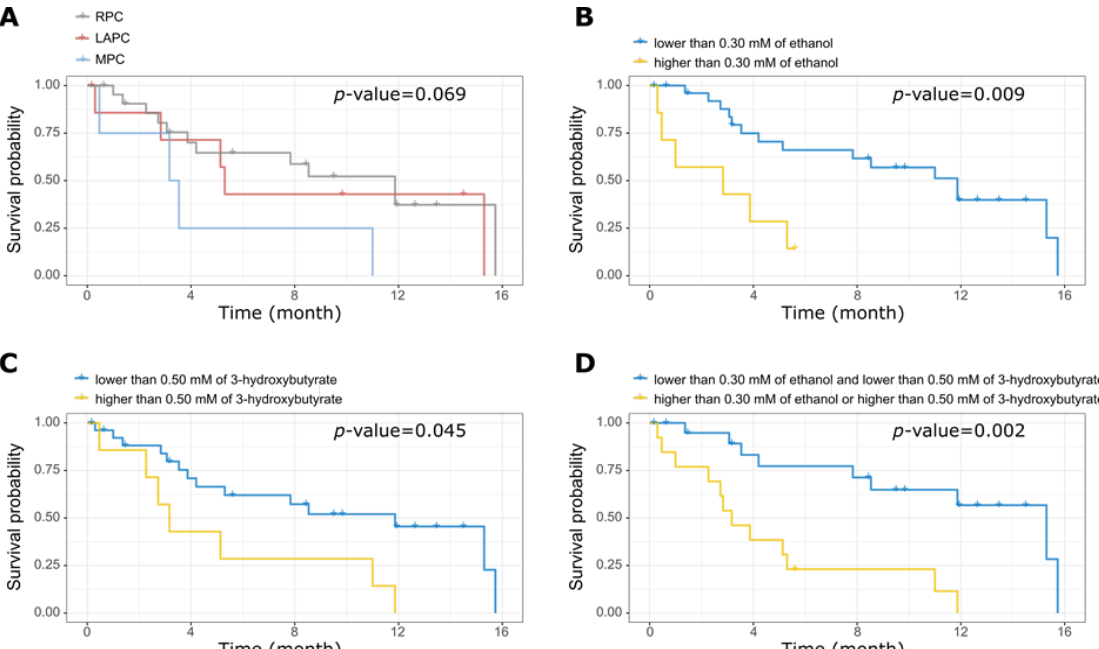
Figure 3. Impact of tumour stages and metabolites concentration on patient survival. Kaplan–Meier survival curves showing effect of ( A ) Tumour stage, ( B ) Ethanol, ( C ) 3-hydroxybutyrate, and ( D ) combination of ethanol and 3-hydroxybutyrate with survival time. There was no significant link between tumour stages and patient survival. PDAC patients with low levels of both ethanol and 3-hydroxybutyrate survived longer. RPC: Resectable Pancreatic Adenocarcinoma; LAPC: Locally Advanced Pancreatic Adenocarcinoma; MPC: Metastatic Pancreatic Adenocarcinoma.